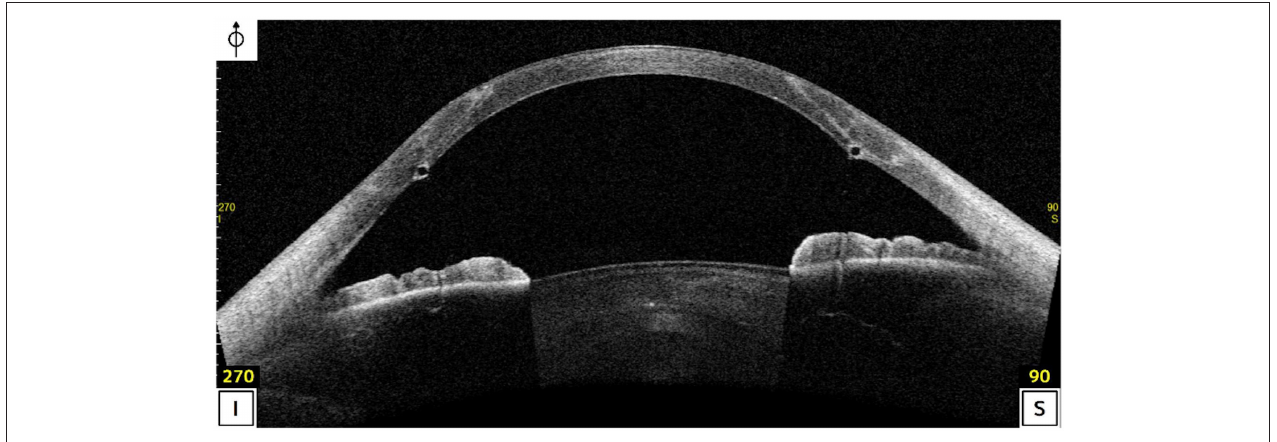
FIGURE 5 | Anterior Segment Optical Coherence Tomography (AS-OCT; Casia II- OCT, Tomey, Japan) 24-months